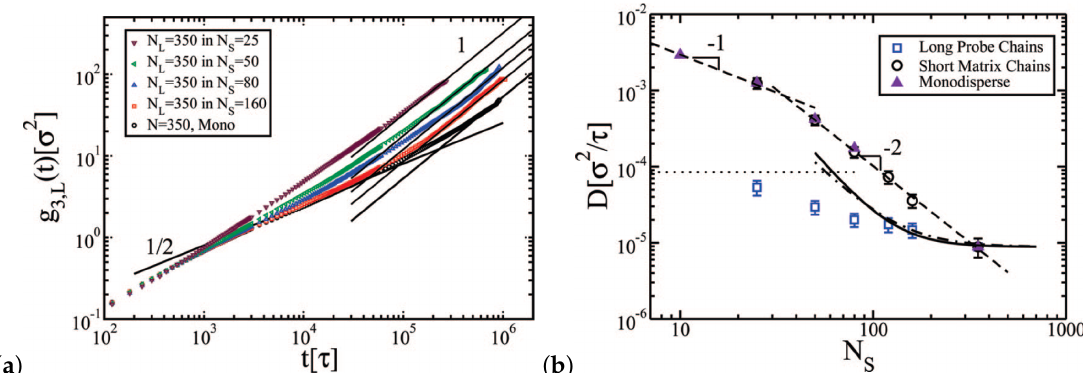
Figure 6. ( a ) Mean square displacement (MSD) of center of mass g 3 ( t ) of the long probe chains with N = 350 monomers in binary blends with various short matrix chains N s [80]. ( b ) Diffusion coefficients of the long probe chains with length N = 350 and the short matrix chains, as a function of the matrix chain length of the short chains, N s , in binary blends with fixed long chain segment fractions n L = 15%. The triangles are simulation results obtained from monodisperse melts with fixed chain segment number density ρ = 0.85 (Lennard-Jones units). The thick solid and dotted-dashed lines are the predictions of Equations (1) and (2), respectively, using the z and K values from the experimental work of Green and Kramer [43]. The dotted horizontal line shows the Rouse diffusivity of the probe chains, attained in the matrix offering only frictional, and not topological, resistance to the long chain motion. Reprinted from [80] with permission from ACS.